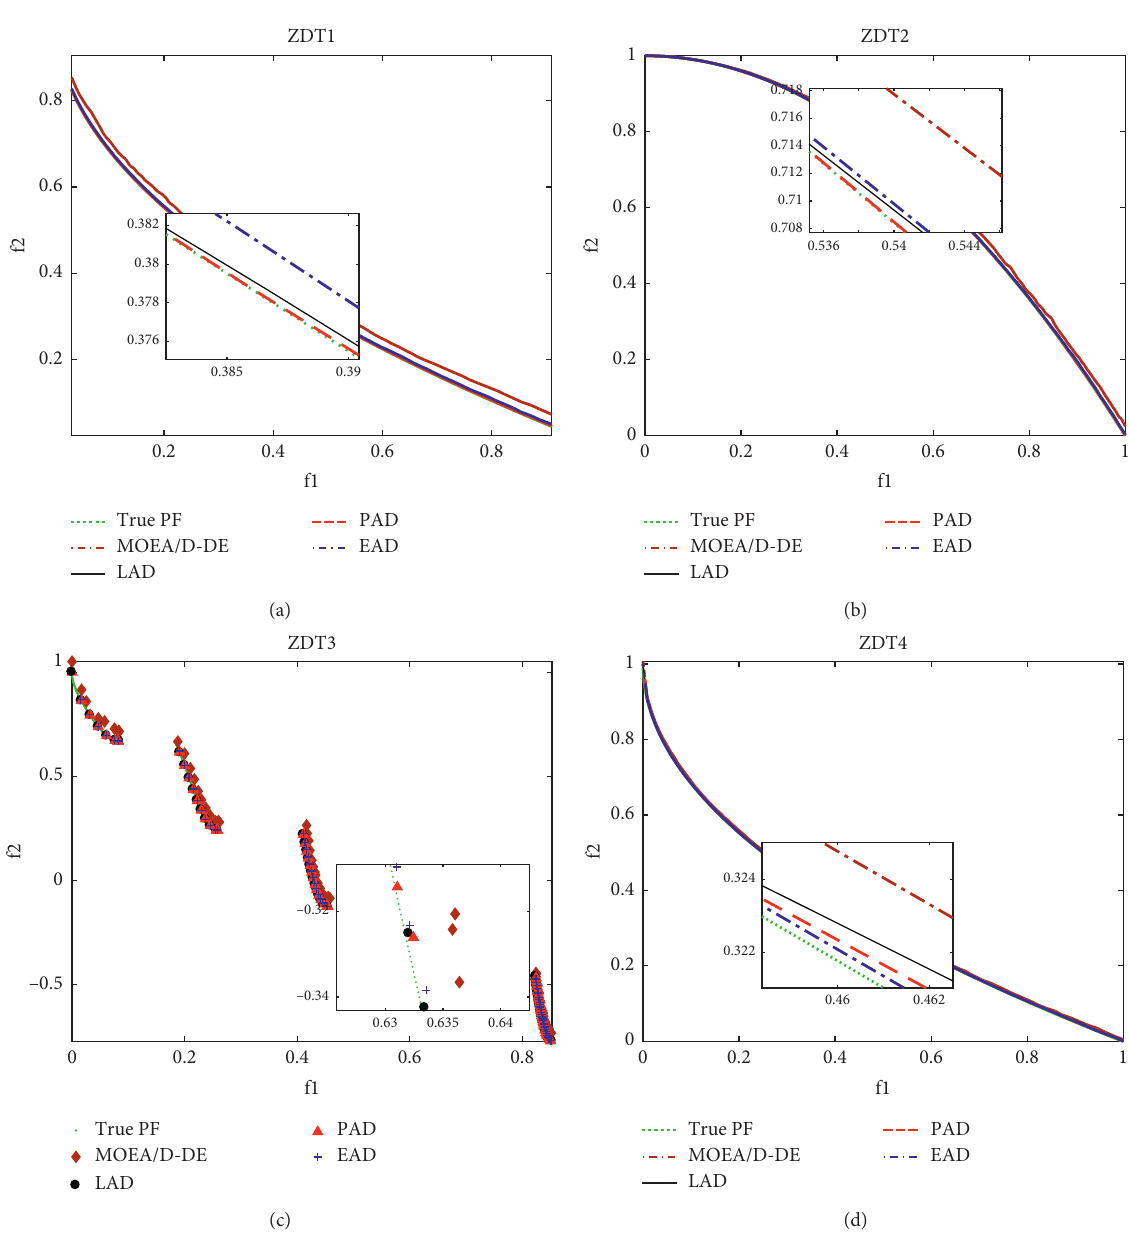
Figure 4: Attainment surfaces for (a) ZDT1, (b) ZDT2, (c) ZDT3, and (d) ZDT4.